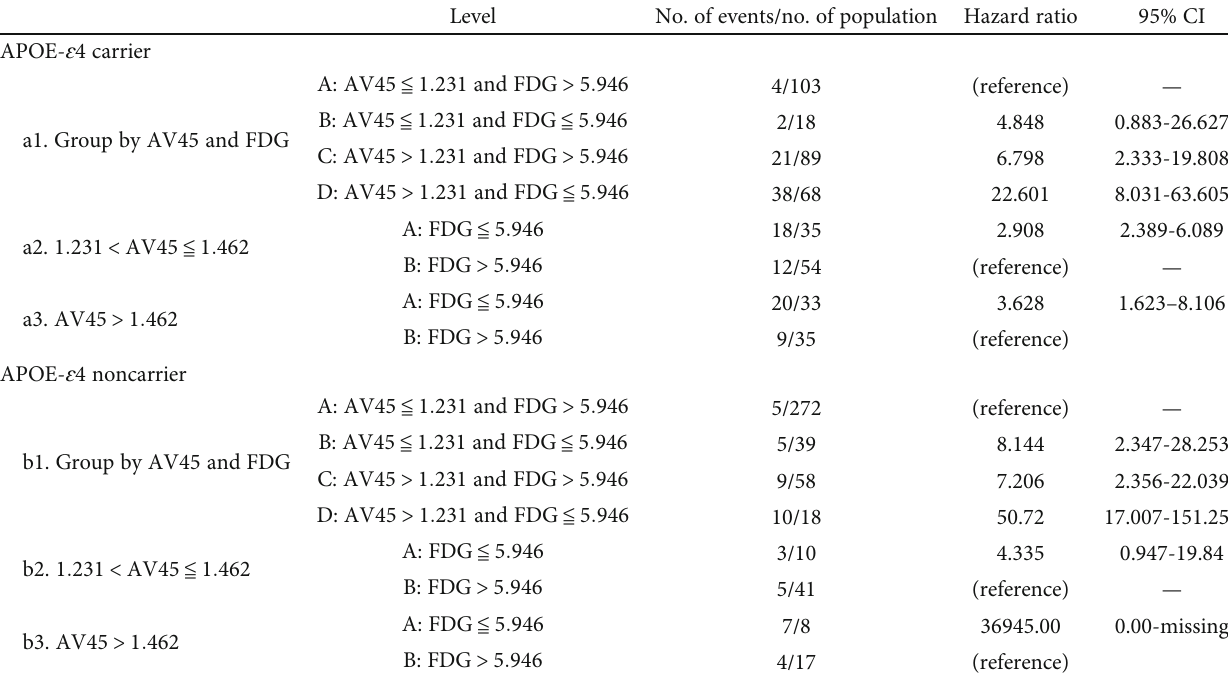
Table 3: Risk classi fi cation by brain Abeta and FDG strati fi ed by ApoE. Level No. of events/no. of population Hazard